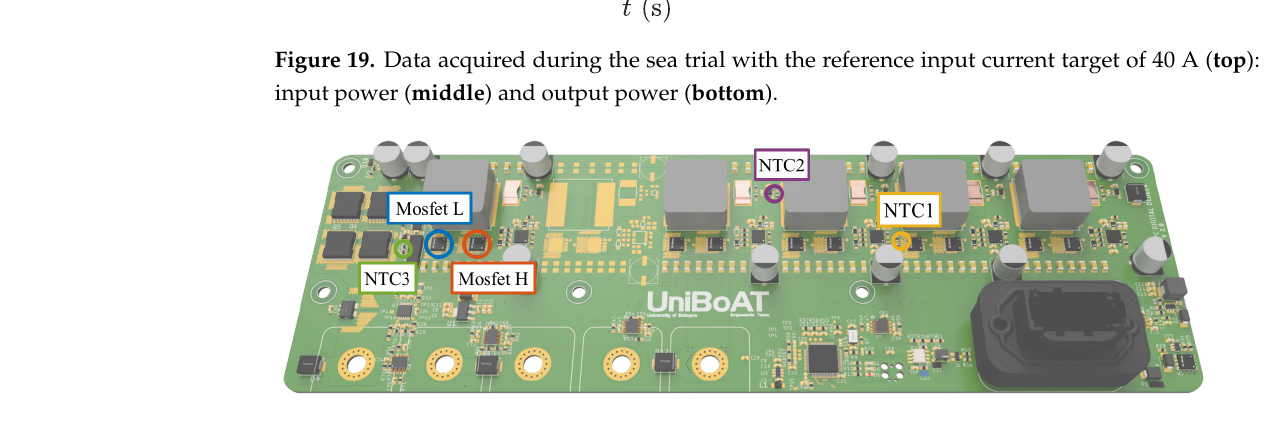
Figure 20. Placement of the temperature sensors on the PCB and